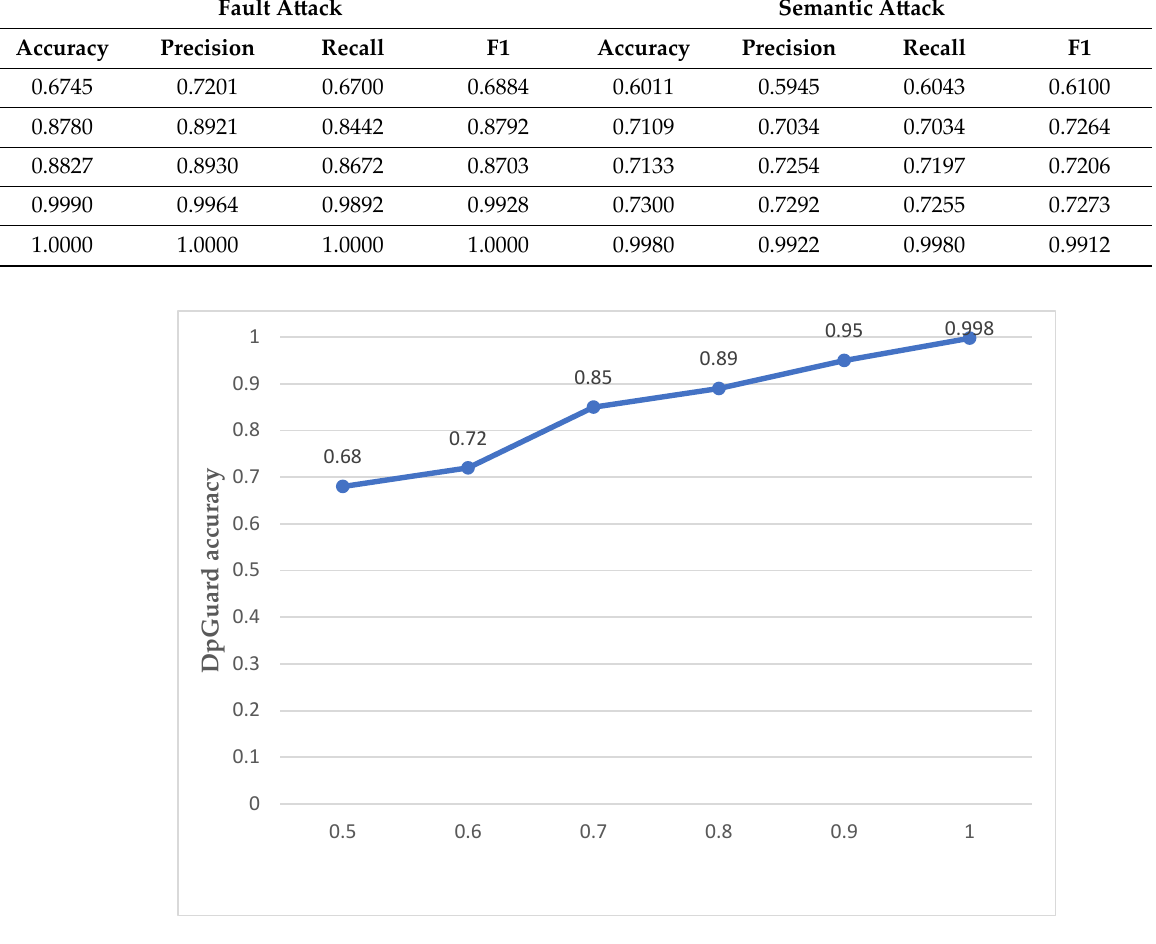
Table 5. Test results and comparison.